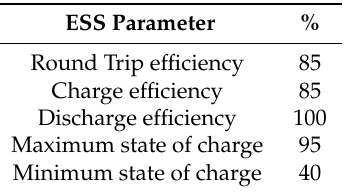
Table 2. Energy Storage System